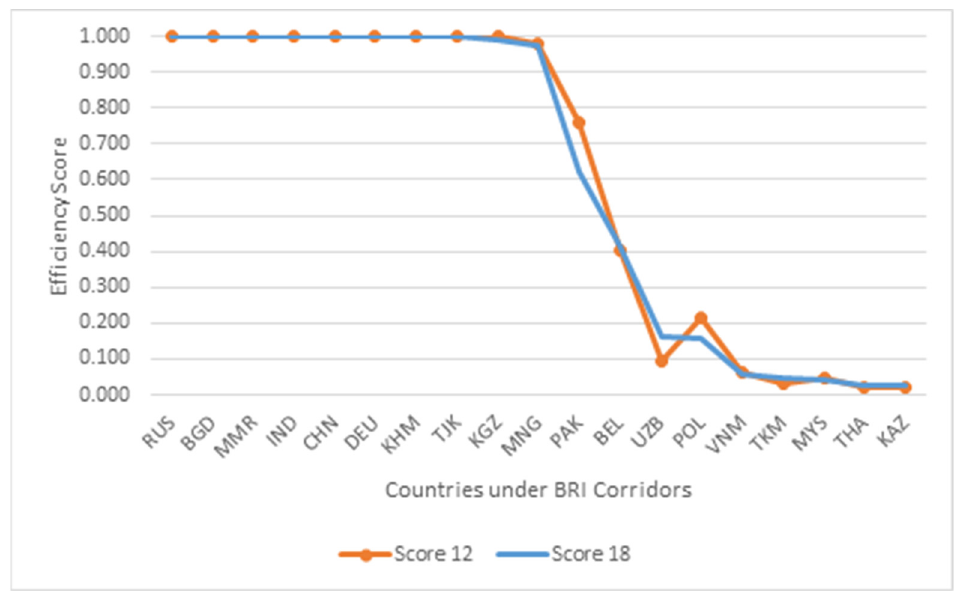
Figure 4. The efficiency score of countries under pre- and post-BRI corridors’ development period. Figure 4. The e ffi ciency score of countries under pre- and post-BRI corridors’ development